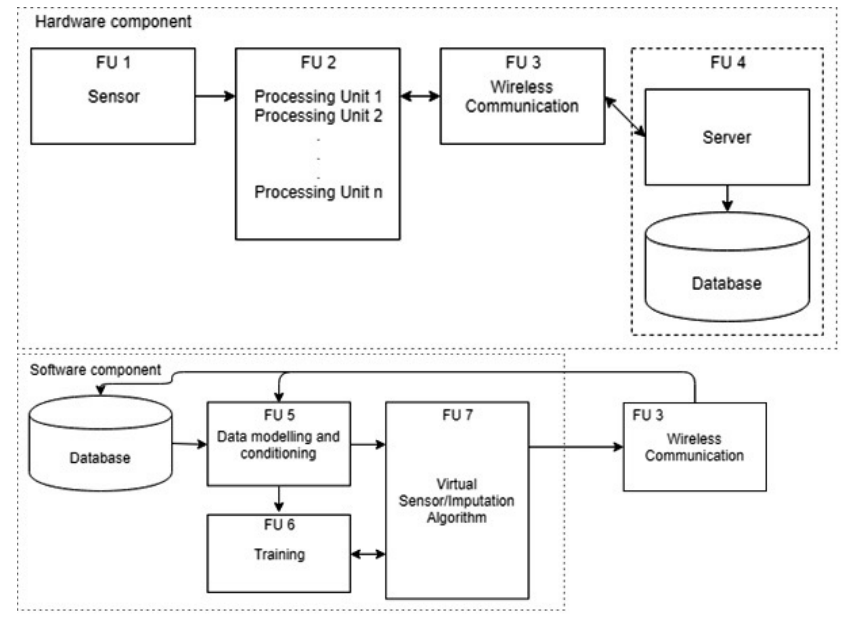
Figure 1. Conceptual design of the virtual sensor